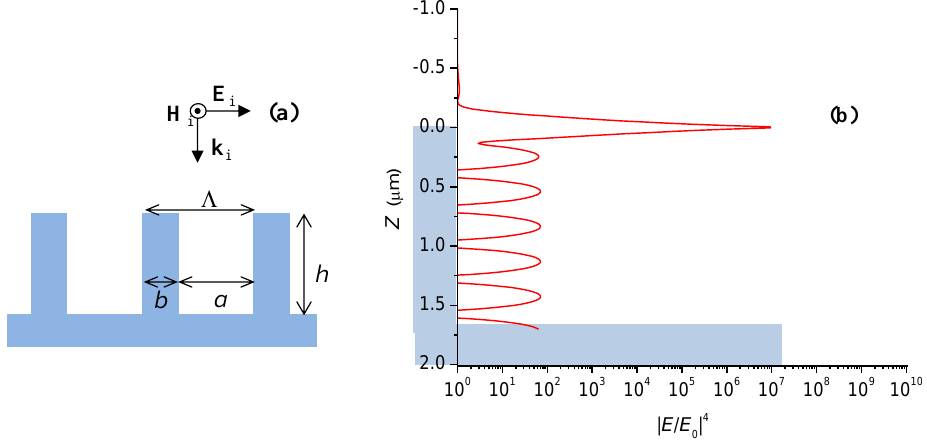
Figure 6. ( a ) Schematic model of a rectangular metallic grid. A TM polarized wave is incident normally on the grating, along the wavevector k i . The electric field E i of the wave is perpendicular to the metallic sheets (i.e., along the propagation direction of the grid); the magnetic field H i is parallel to the edges of the grooves. ( b ) Local electrodynamic enhancement factor 𝑔(𝐫) = |𝐸/𝐸 0 | 4 over vertical surface of the silver sheet under resonant conditions. Z -coordinate represents the depth below the edge of the silver sheet.